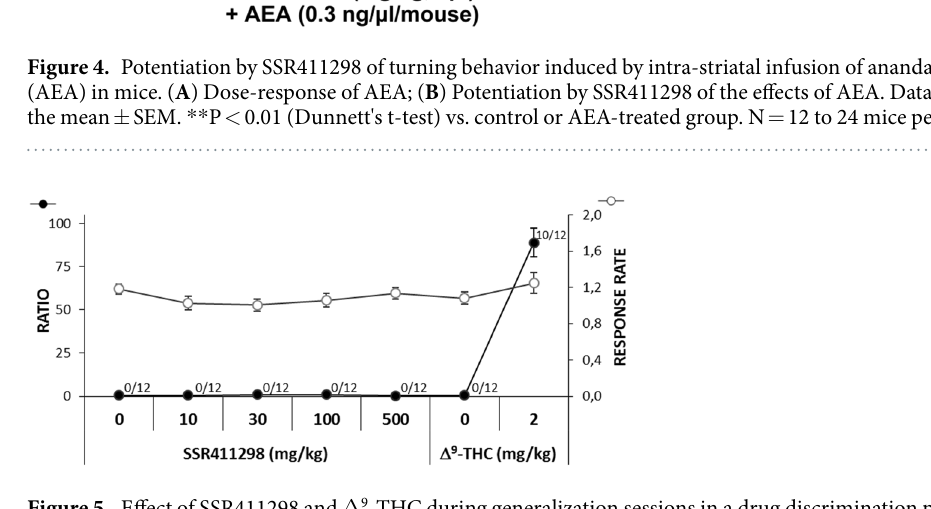
Figure 5. Effect of SSR411298 and Δ 9 -THC during generalization sessions in a drug discrimination procedure. The ratio represents the percentage of responses on the WIN 55,212-2-associated hole ( ● ). Response rate is the number of responses per second ( ○ ). The number alongside each ( ● ) symbol indicates the number of animals with complete generalization to WIN 55,212-2. SSR411298 at 10, 30, 100 and 500 mg/kg produced no generalization to WIN 55,212-2 whereas Δ 9 -THC produced complete generalization to WIN 55,212-2 in 10/12 rats. Data represent the mean ± SEM. N =